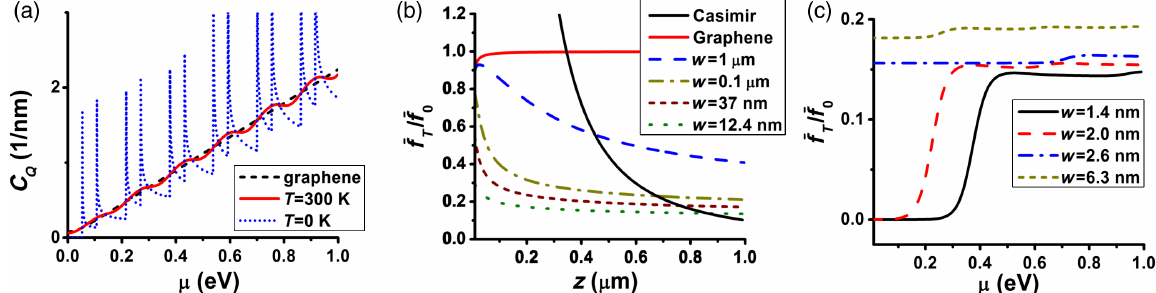
FIG. 2. (a) C as a function of chemical potential for graphene and a GNR with w ¼ 12 . 4 nm. (b) Charge fluctuations thermal force Q ¯ f 0 ¼ − k T= ð 2 Az Þ . The area of all ribbon structures is 1 μ m 2 and μ ¼ 0 . 1 eV. The graphene-metal Casimir force normalized by B ¯ f 0 at room temperature is also shown. The metal plasmon energy is taken as ℏ ω normalized by fluctuations thermal force versus chemical potential for different GNRs at T ¼ 300